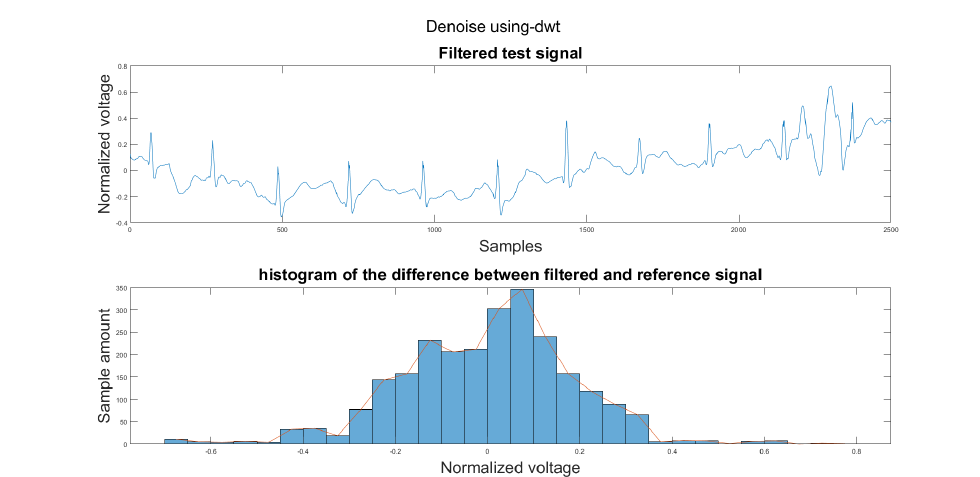
Figure A32. (1) Test signal, (2) histogram of the